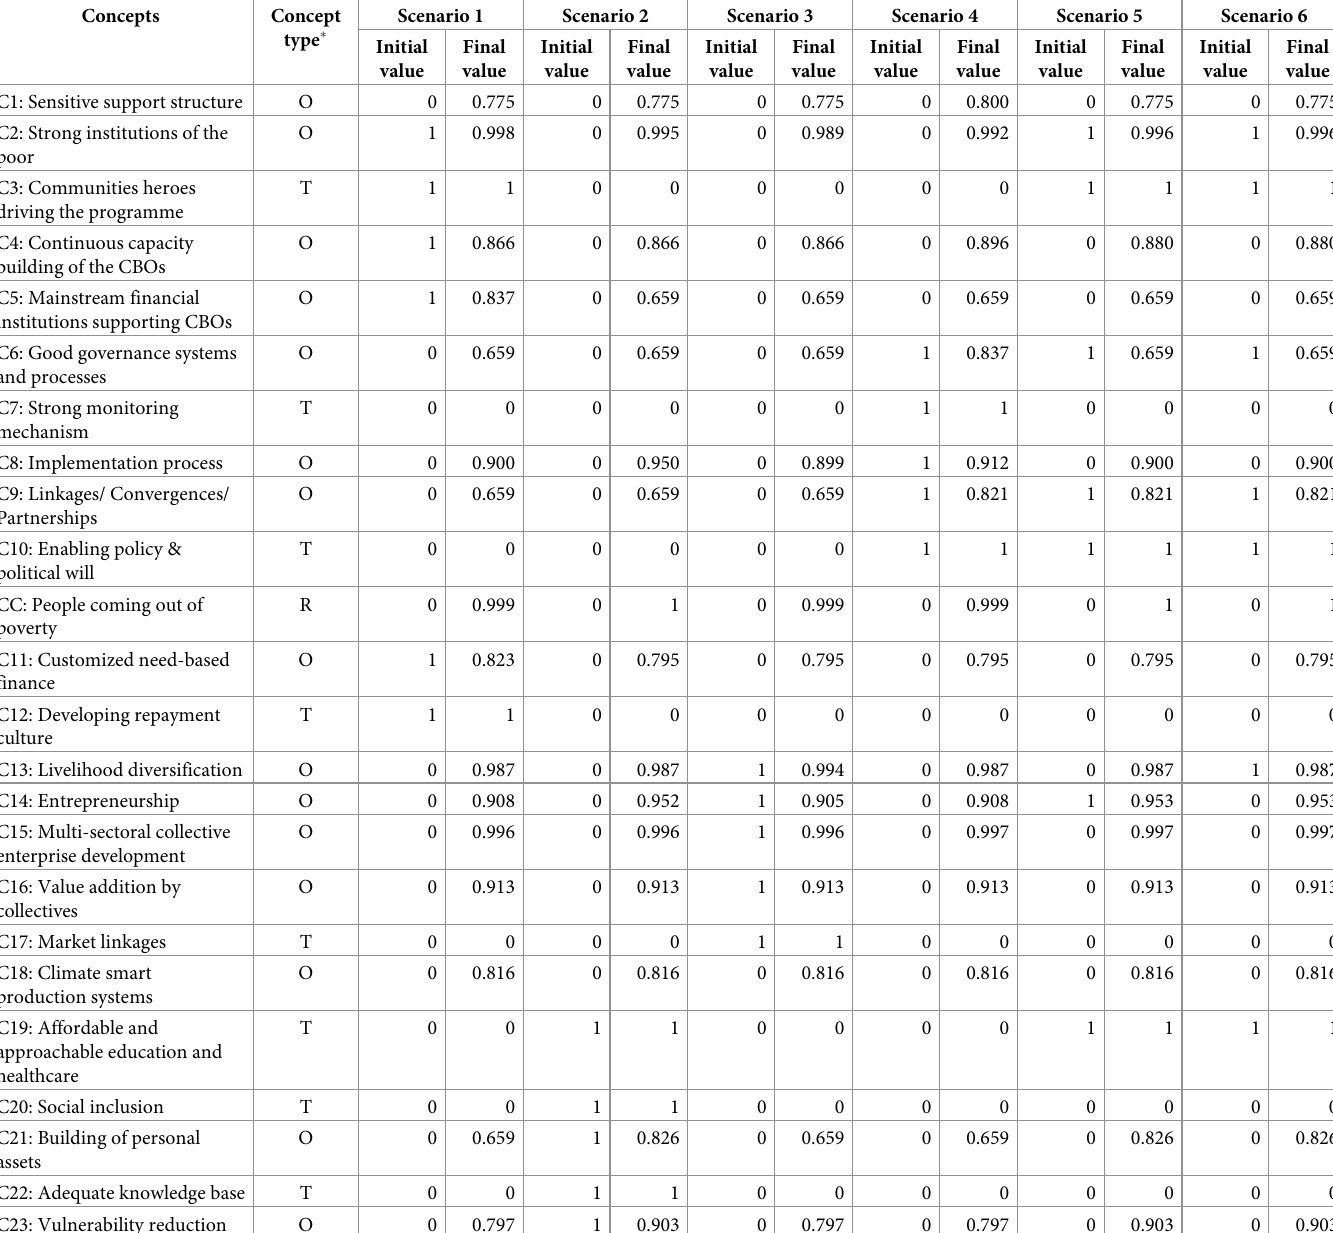
Table 2. Initial and final values of all the concepts for every FCM-based